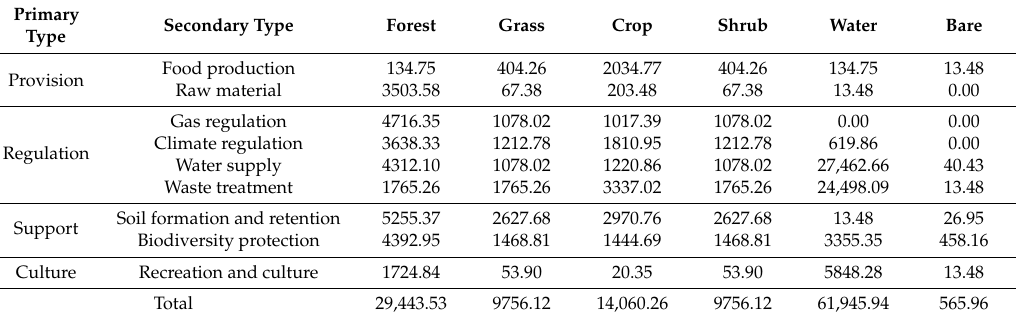
Table 2. Values of each ecosystem service per unit area in Jiangxi province (unit: Yuan / hm 2